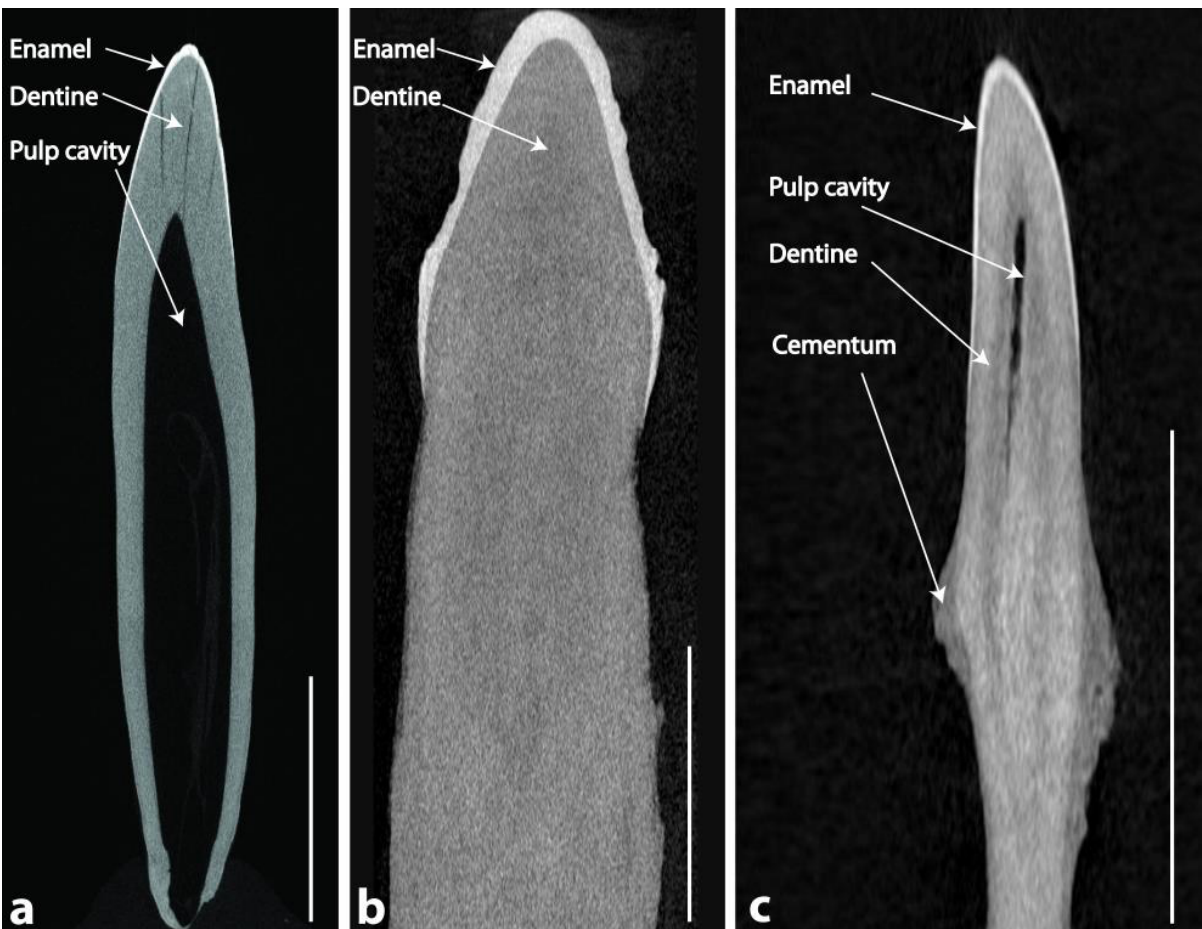
Fig. 1. Internal morphology of extant odontocete teeth revealed by Micro-CT. Note the resolution of enamel, dentine, cementum and the different stages of obliteration of the pulp cavity, but no clear growth layer groups. Scale bar = 10 mm. a) Pilot whale Globicephala sp.